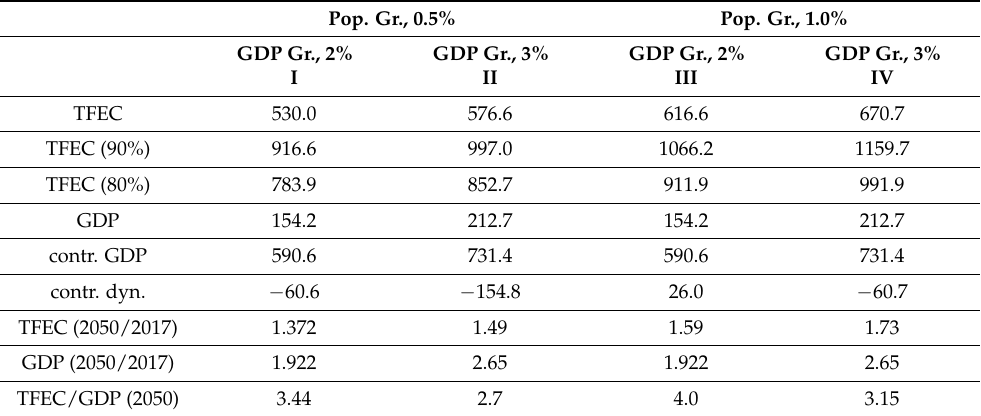
Table 1. Main simulation